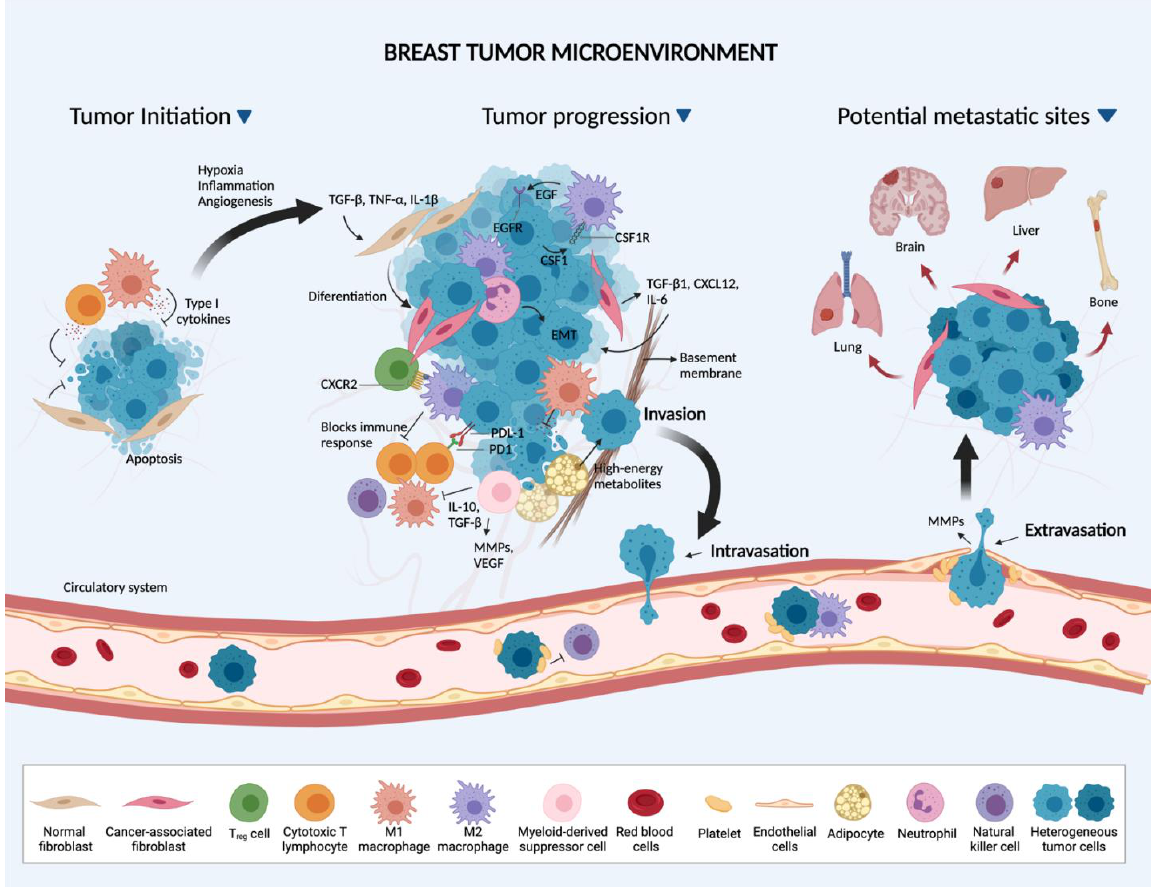
Figure 1. The tumor microenvironment (TME) and breast cancer progression. At the onset of tumor initiation, the developing tumor is exposed to growth-suppressive signals from the inflammatory process, which is primarily modulated by cytotoxic T-lymphocytes, M1 macrophages and fibroblasts. The BC cells overcome these mechanisms by educating host stroma cells to acquire pro-tumorigenic features. Cytokines (TGF- β , IL-1 β and TNF- α ) released from the inflammatory process then modulate the differentiation of normal fibroblasts to cancer-associated fibroblasts (CAFs). The latter, in turn, secrete extracellular matrix proteins and soluble factors (TGF- β , CXCL12, IL-6) that stimulate epithelial to mesenchymal transition (EMT), tumor growth and progression. Neutrophils can induce EMT and promote tumor progression through cytokines release. Adipocytes secrete high-energy metabolites to fuel tumor growth. Tumor-associated macrophages (primarily M2 macrophages) support various processes within the TME, including BC growth and invasion by secreting pro-tumorigenic cytokines and growth factors. During tumor expansion, activated cytokines in the environment (CXCL5-CXCR2, TGF- β ) stimulate the recruitment of regulatory T cells (T reg ) and myeloid-derived suppressor cells (MDSCs) which disrupt immune surveillance by inhibiting cytotoxic T lymphocytes, M1 macrophages and natural killer cells. BC cells can also escape immune surveillance by overexpressing the PD-L1 ligand. Such orchestrated events in the primary tumor allow tumor cells to acquire a mobile and invasive phenotype. Secreted factors (MMPs, VEGF) further facilitate tumor cells intravasation into the circulation. There, BC cells interact with platelets and M2 macrophages to support their survival by inhibiting immune recognition. Platelets escort tumor cells to the secondary sites, where it interacts with endothelial cells and promote extravasation. The preferred site of metastasis can be influenced by the subtype of the BC (Created with BioRender.com, accessed on 12 September